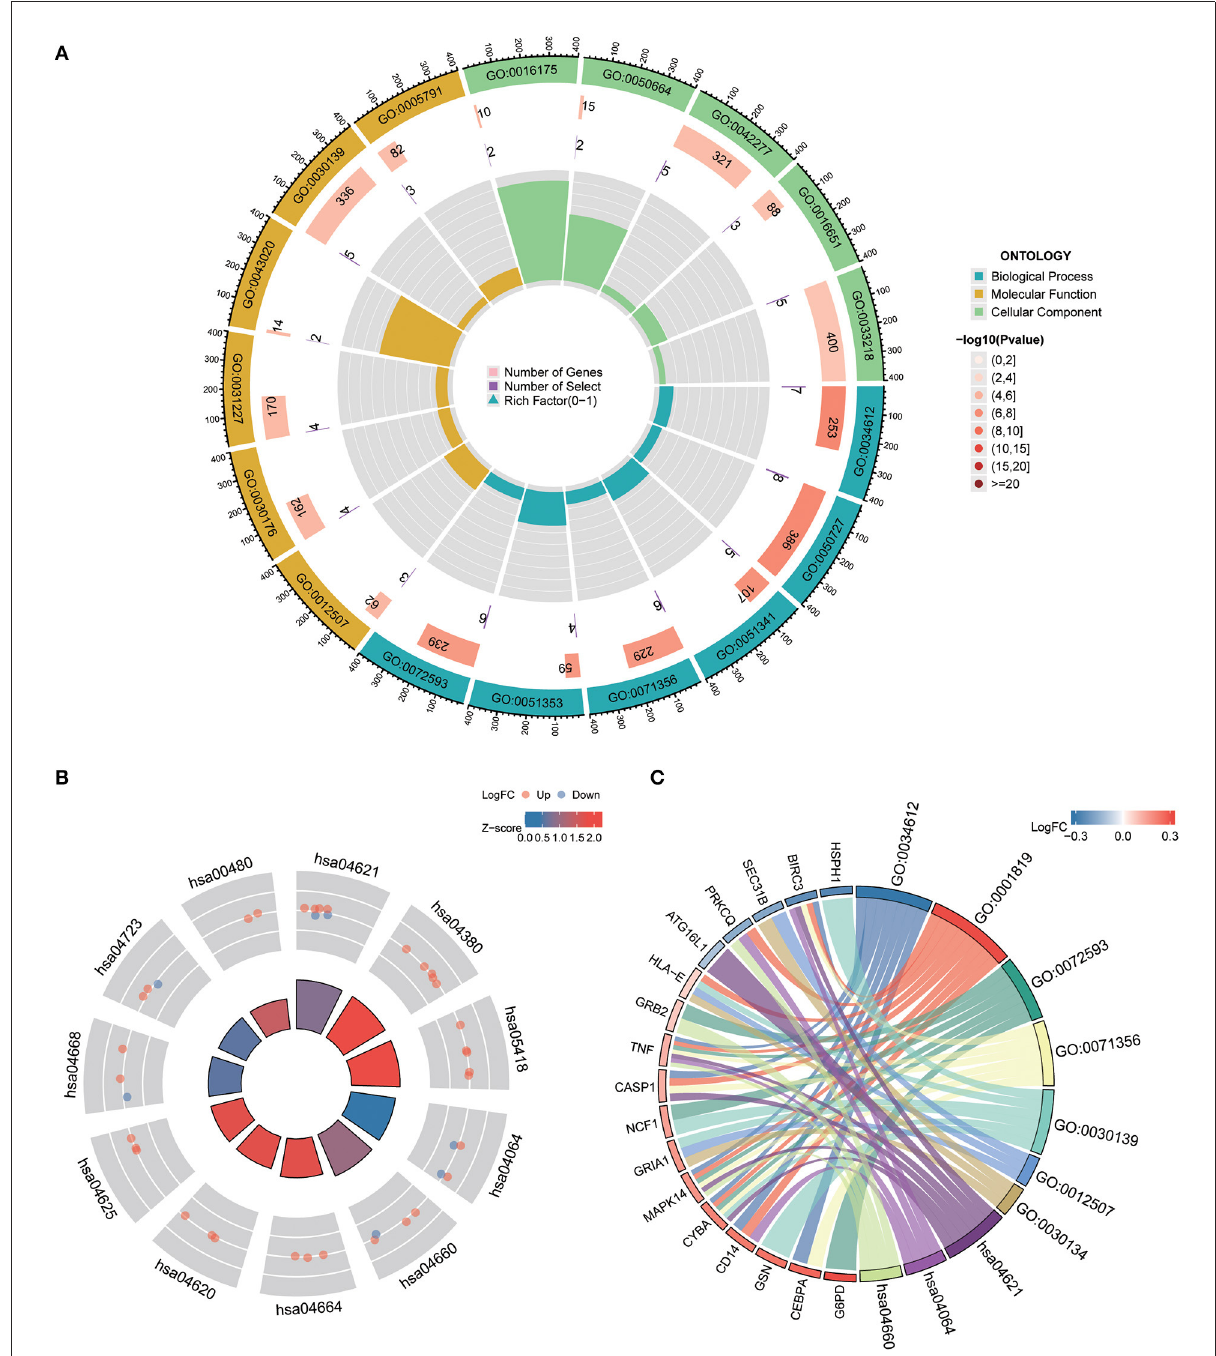
FIGURE5 GO functional and KEGG pathway enrichment analysis of ERSR-DEGs. (A) GO enrichment analysis of ERSR-DEGs. (B) KEGG pathway analysis of ERSR-DEGs. Red nodes suggest upregulated genes, and blue nodes mean downregulated genes. Quadrilateral color indicates Z-score. Red indicates a positive Z-score (activated function), and blue indicates a negative Z-score (inhibited function). (C) The chord plot displays the relationship between ERSR-DEGs and GO and KEGG